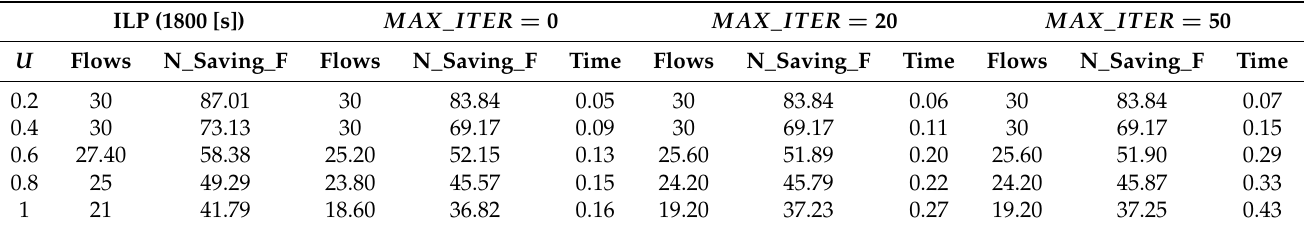
Table 4. Eight servers-30 flows-Flow scheduling with Simple heuristics in phase.